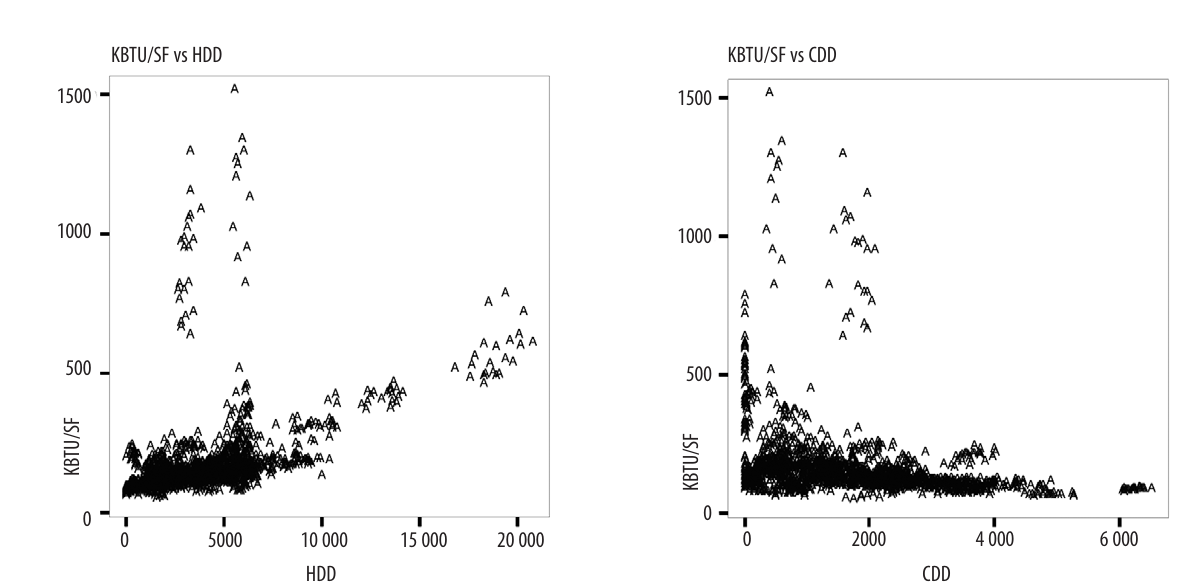
Fig. 3. Scatter plots for HDD and